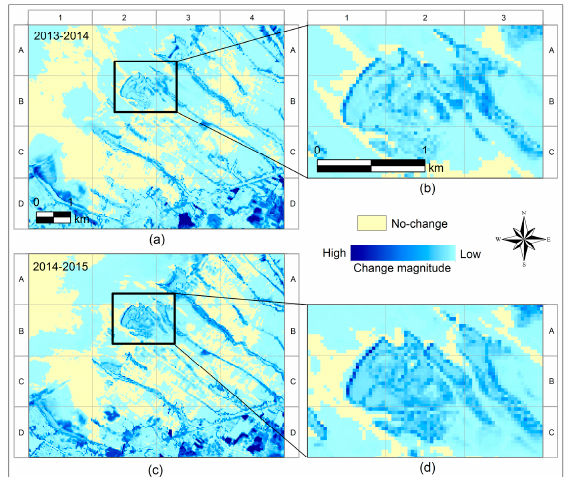
Figure 5. The magnitude of shoreline change during: 2013–2014 ( a , b ); and 2014–2015 ( c , d ). The magnitude values vary from high magnitude represented by dark blue pixels up to low magnitude represented by light blue pixels, whereas light yellow pixels show the no-change areas.